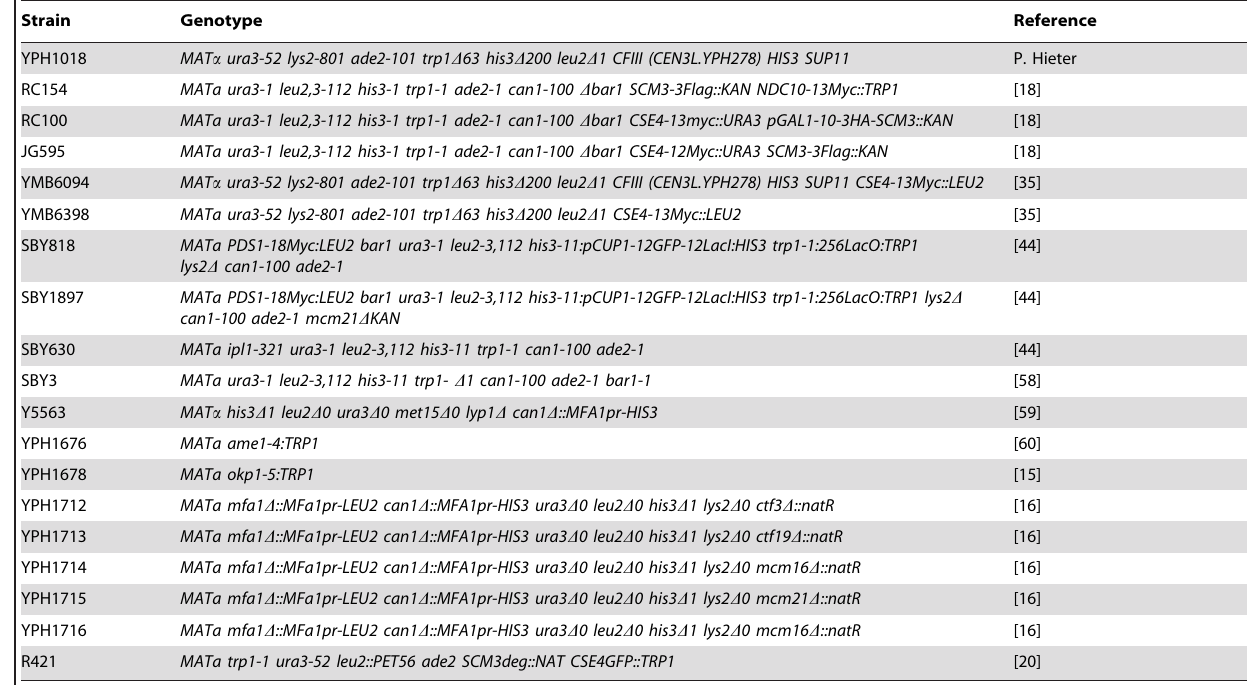
Table 1. S. cerevisiae strains used in this study.